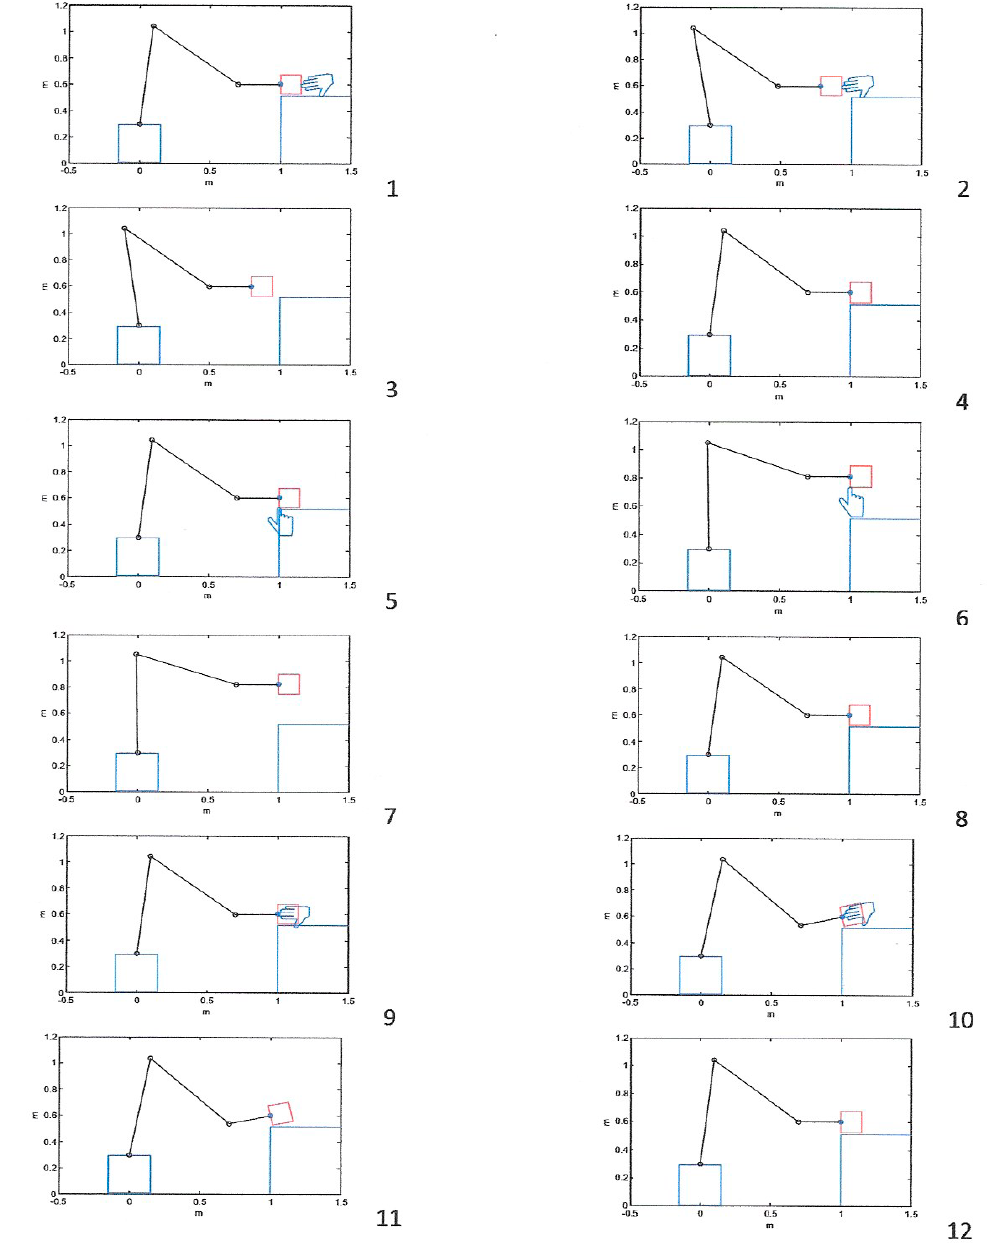
Figure 33. Selected phases of the interaction in the hypothesis of an impedance as in Figure 30a). (1–4 horizontal motion; 5–8 vertical motion; 9–12 angular